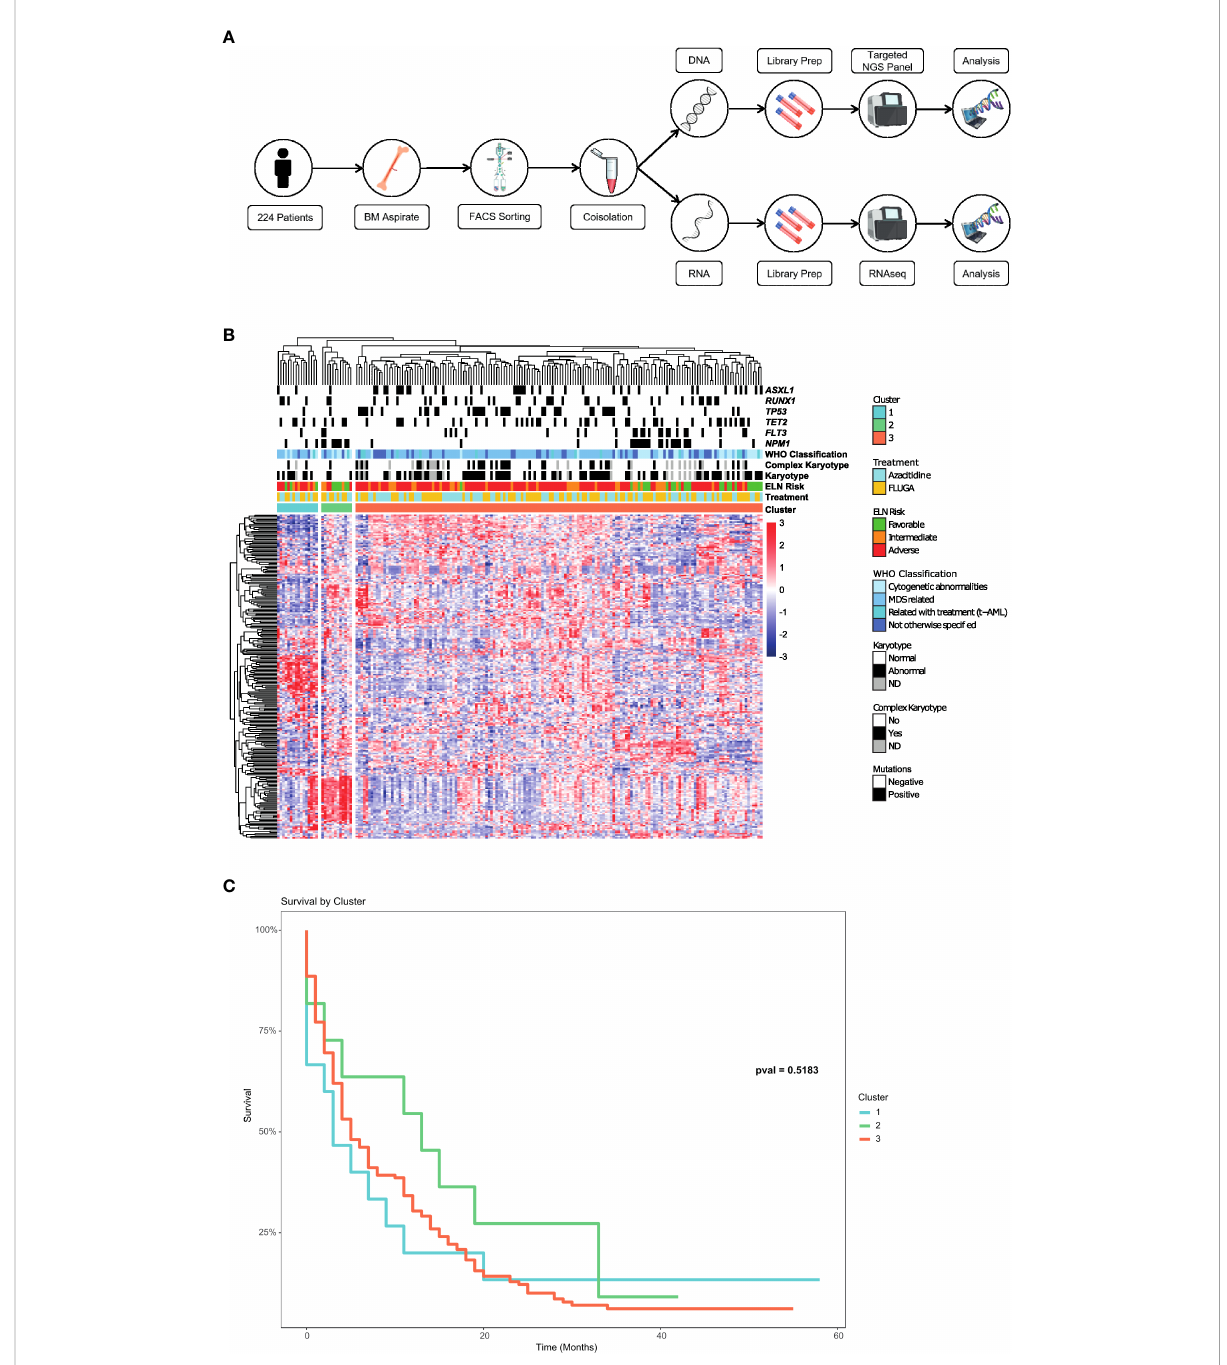
FIGURE 1 Identi fi cation of a long survival group beyond 12 months in elderly AML patients. (A) Scheme of the process carried out to obtain the RNAseq and mutation data through a myeloid NGS panel in AML samples of the PETHEMA-FLUGAZA clinical trial. (B) Unsupervised hierarchical clustering of the entire AML patient cohort using full transcriptional pro fi ling, identifying 3 different groups. (C) Overall survival analysis of the 3 different AML groups based on the transcriptional pro fi